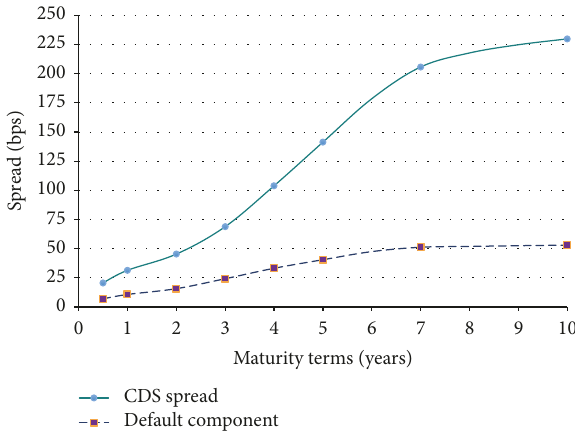
Figure 6: Goodyear Company term structures: CDS spread and default component.